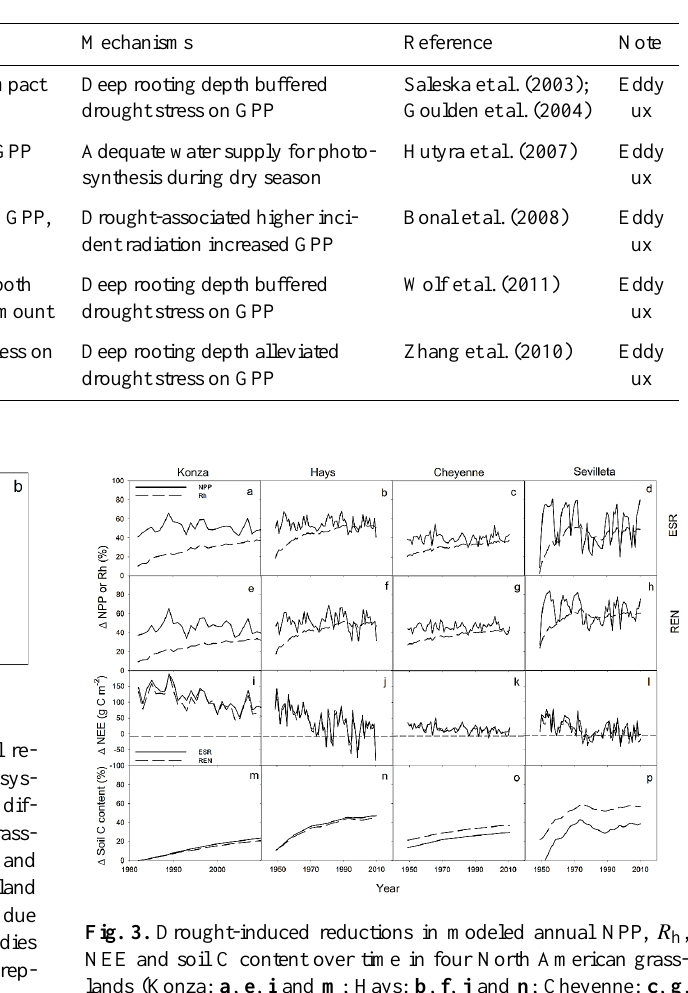
Table 3. Synthesis of published studies on the differential responses of GPP and ER to extreme seasonal drought in tropical rainforest.